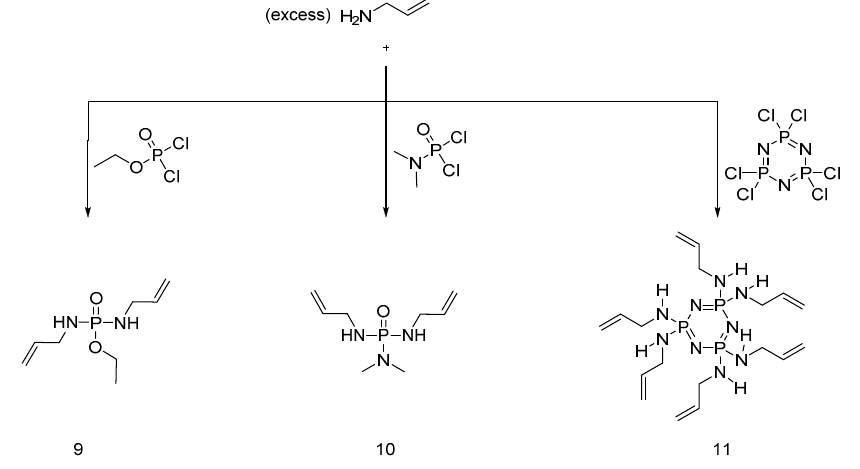
Figure 7. Representative schematic synthesis of UV-curable monomers ( 9 ), ( 10 ) and ( 11 ).